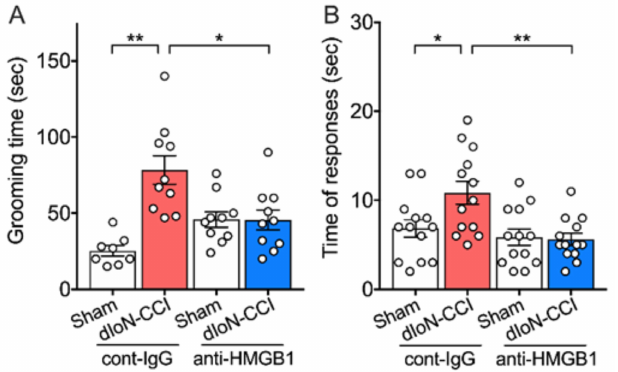
Figure 5. Effect of anti-HMGB1 nAb treatment on pain-related behavior in dIoN-CCI mice. ( A ) Total facial grooming time ( n = 8–10 per group) and ( B ) total response time to acetone ( n = 13 per group) were assessed 7 and 13 days after the surgery, respectively. Data are expressed as individual and mean ± SEM. * p < 0.05, ** p < 0.01 compared with sham-operated (Two-way ANOVA, Sidak’s correction for multiple